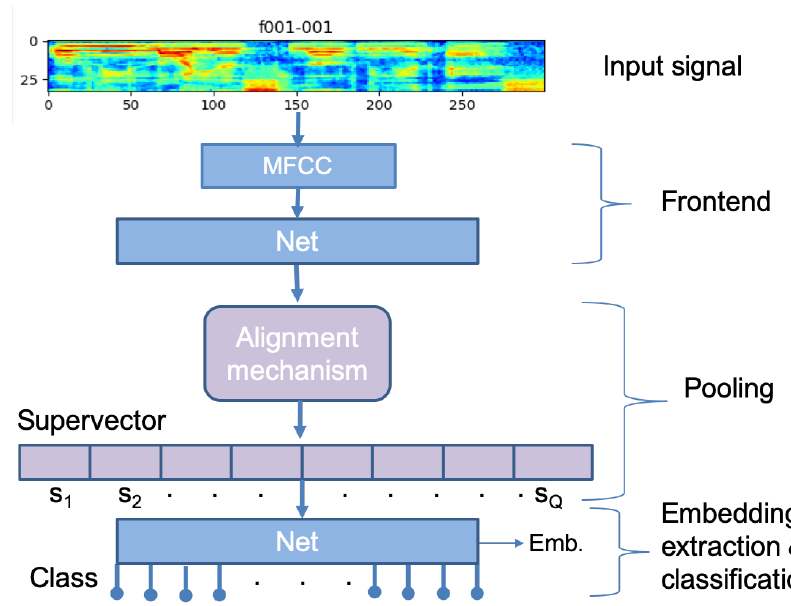
Figure 1. Differentiable neural network alignment mechanism based on alignment models. The supervector is composed of Q vectors s Q for each